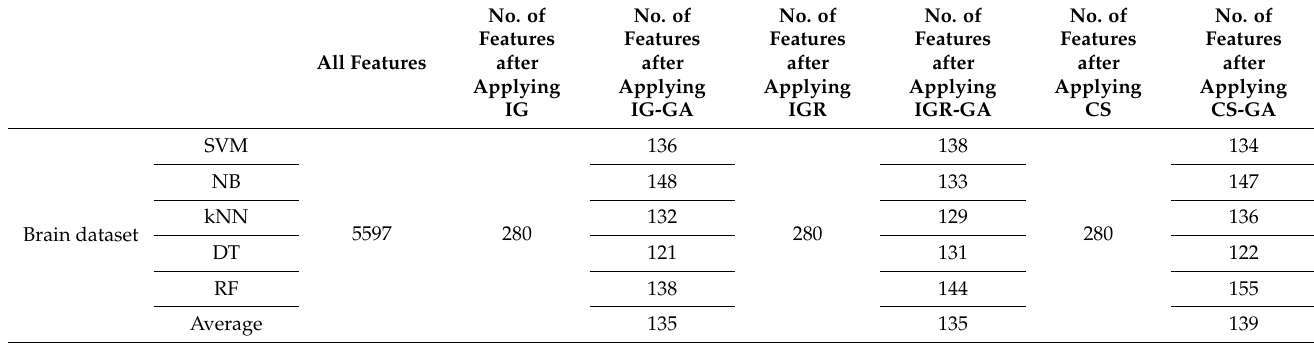
Table 7. Comparison of the selected features numbers before and after applying the proposed hybrid filter-GA feature selection